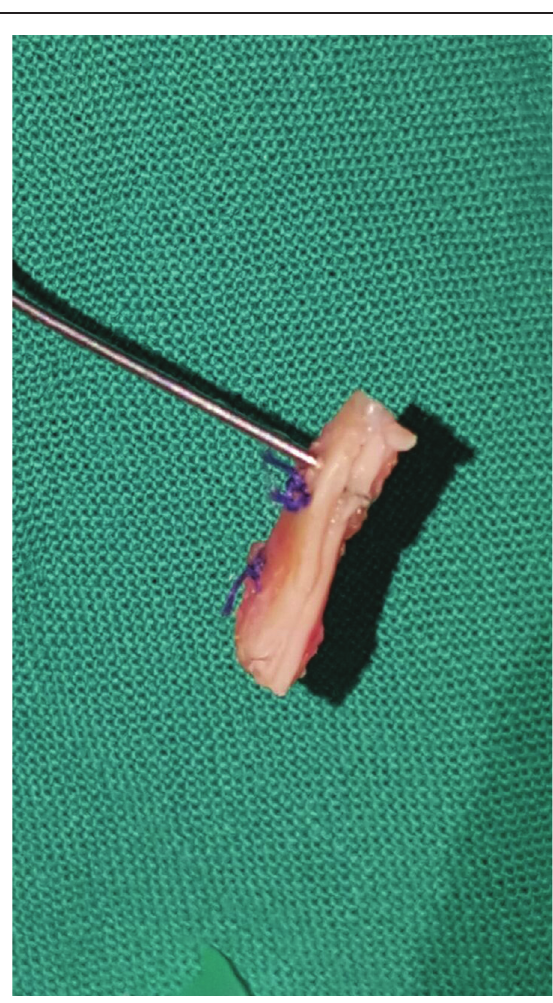
Double-layered tragal cartilage with its